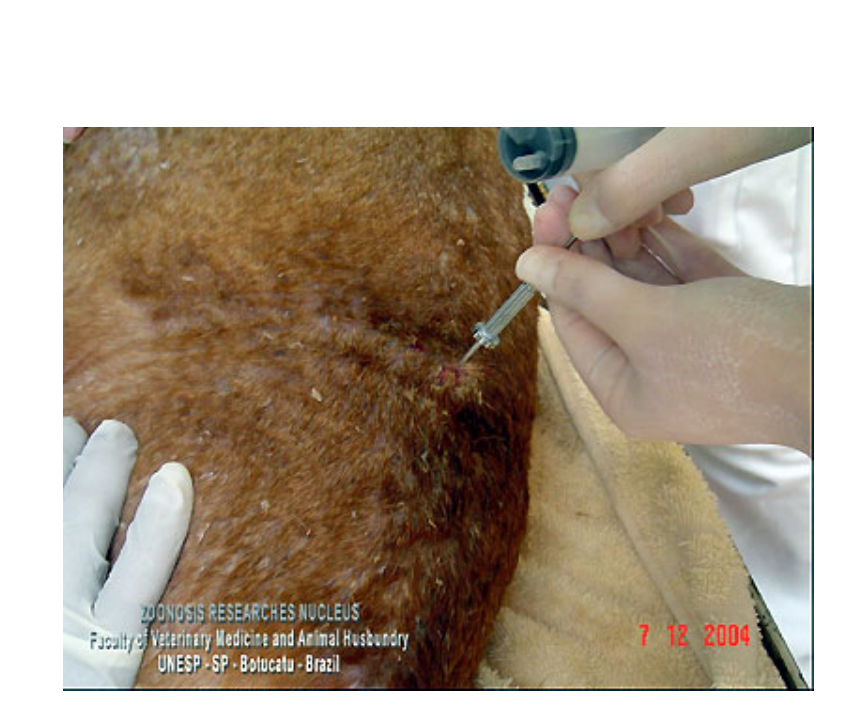
Figure 3: Puncture of the bone marrow